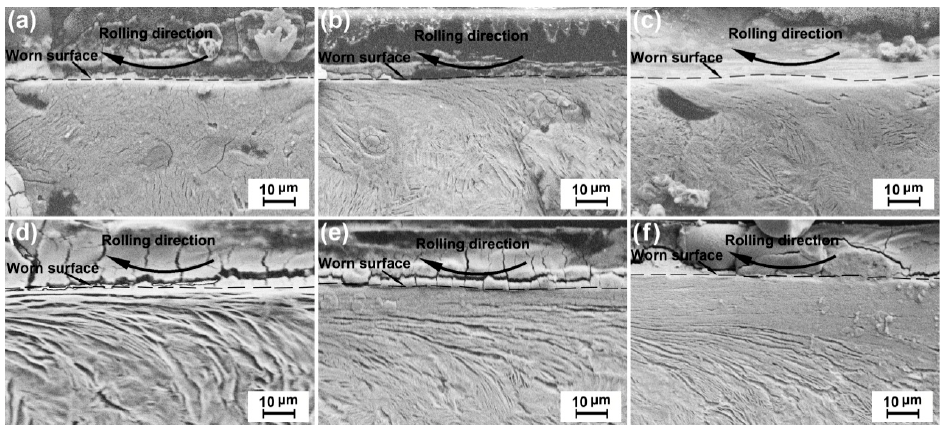
Figure 8. Wheel-material plastic-deformation under different loads at a sliding velocity of 6.3 × 10 4 mm/min: ( a ) D’, 50 N, ( b ) D’, 60 N, ( c ) D’, 70 N, ( d ) S, 50 N, ( e ) S, 60 N, and ( f ) S, 70 N. Materials 2020 , 13 , x FOR PEER REVIEW